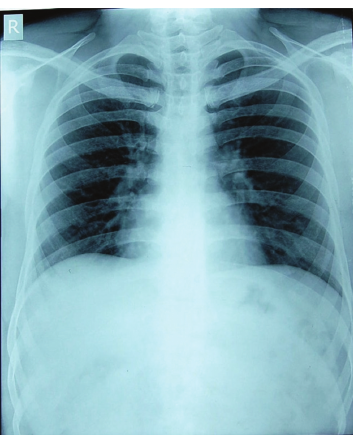
Figure 1: X-ray showing evidence of molar band. Figure 2: X-ray showing no evidence of molar band.